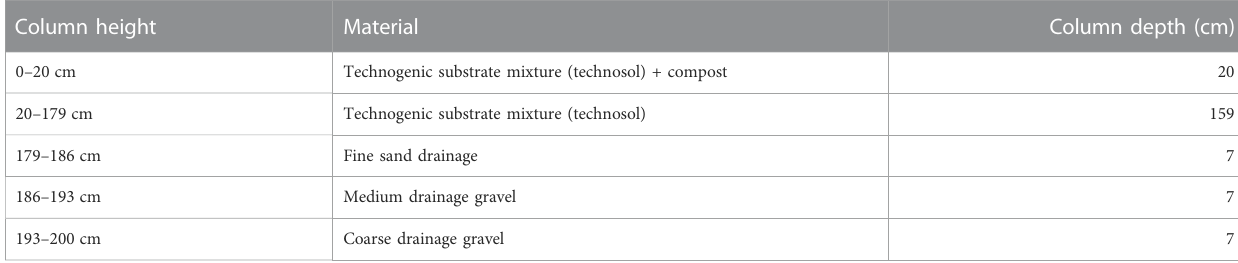
TABLE 2 Composition of the materials used in the column leaching experiment, with layers arranged from top to bottom. Column height